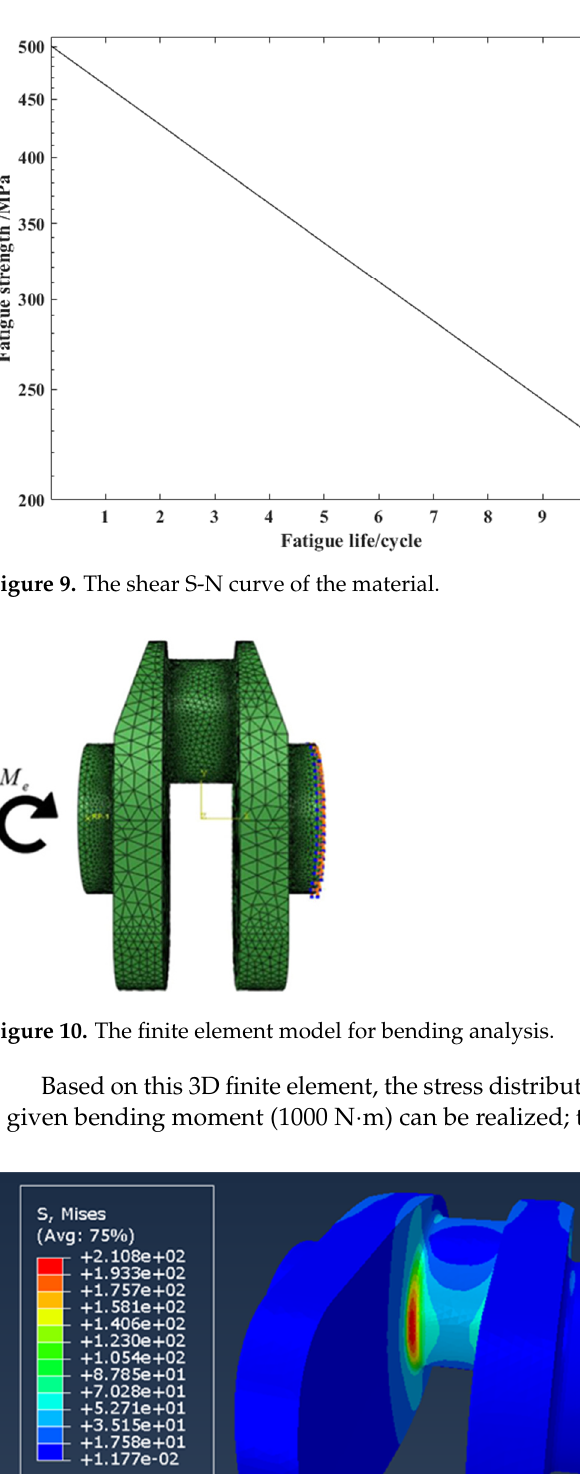
Table 3. Components of the stress sensor of crankshaft N0 from different sources.